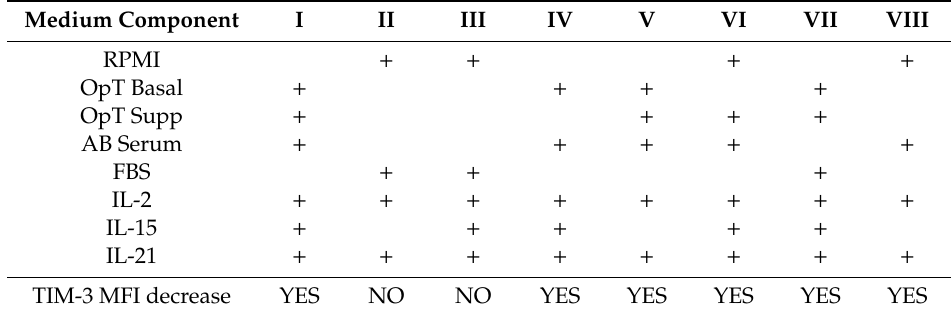
Table 2. Media compositions and their e ff ect on the downregulation of TIM-3 on human NK cells in the presence of cancer cells across eight di ff erent media recipes. ‘ + ’ indicates the media component present in the recipe; ‘YES’ indicates that the recipe resulted in TIM-3 downregulation; ‘NO’ indicates that the media recipe did not result in TIM-3